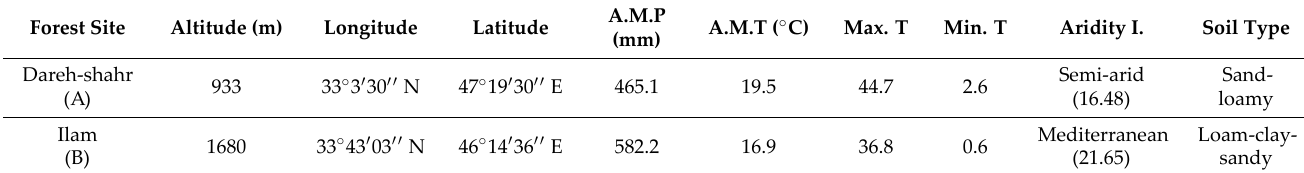
Figure 4. The locations of sampled forests stands on Ilam map, western Iran. Table 3. Main characteristics of the study sites and the precipitation and temperature data from the nearest meteorological